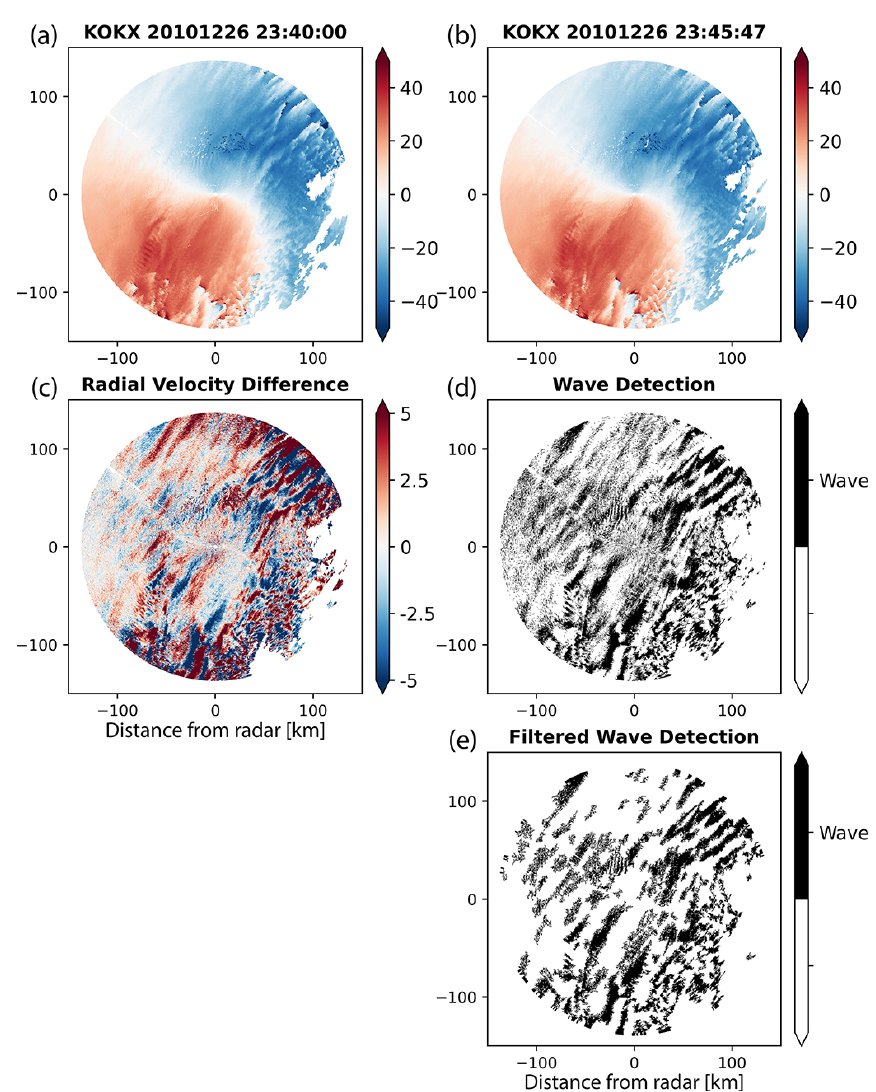
Figure 2. Step-by-step wave detection method illustrated using sequential PPI scans of radial velocity from NWS KOKX radar in Upton, NY, on 26 December 2010. Polar coordinate radial velocity fields at 0.5 ◦ elevation angle for consecutive scans at (a) 23:40:00UTC and (b) 23:45:47UTC. (c) The difference field computed from PPIs (b) minus (a) showing both positive and negative temporal velocity changes. (d) Binary version of the negative portion of the difference field from (c) . (e) Cartesian coordinate (0.5km grid spacing) filtered version of (d) with eight-connected areas < 16km 2 removed. An animated version of this figure is in Video Supplement Animation-Figure-2.